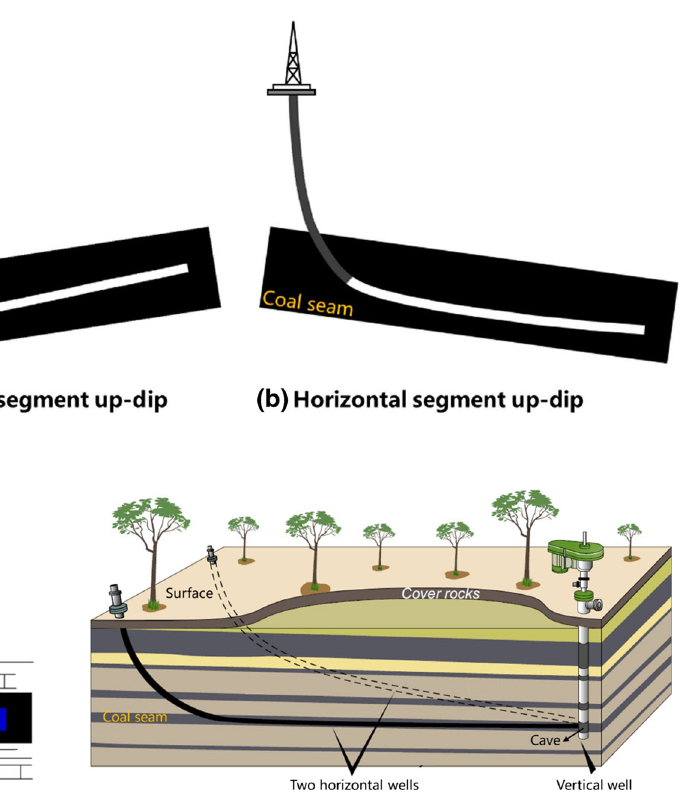
Fig. 6 Schematic of CBM U-shaped horizontal well (Zhang et al. 2013)